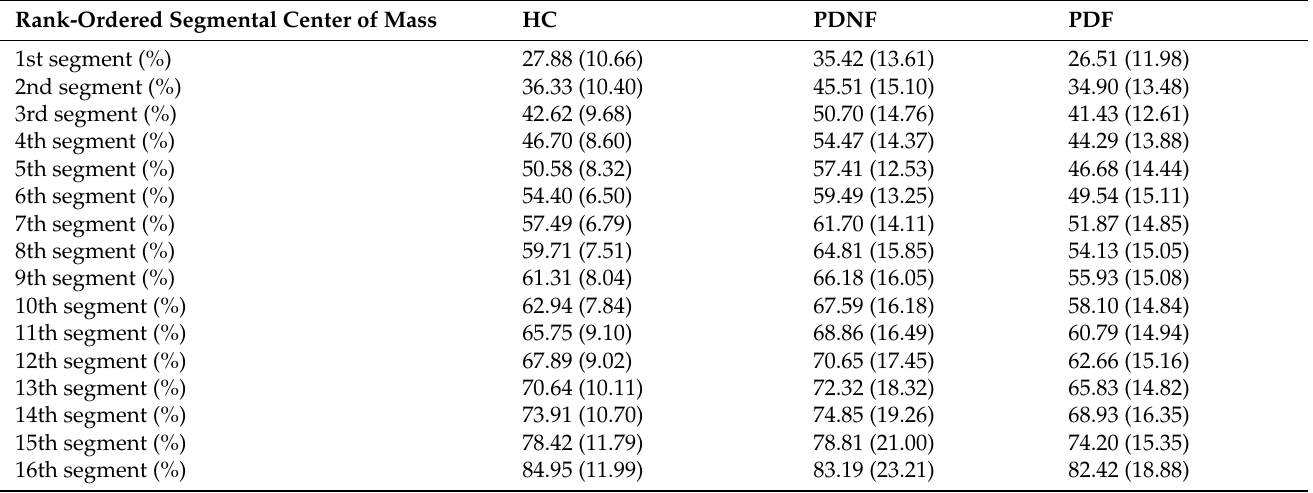
Table 7. Onset of rank-ordered segmental movements at gait initiation. Data are shown as mean (stan- dard deviation). Time of movement onset of rank-ordered segmental centers of mass was expressed as the percentage with respect to total gait initiation duration (i.e., from the onset of the anticipatory postural adjustments to the heel contact of the swing foot) and compared across groups (Dunn’s test, no difference was significant after Bonferroni correction for multiple comparisons). Abbreviations: HC, healthy controls; PDF, Parkinson’s disease with freezing of gait; PDNF, Parkinson’s disease with no freezing of